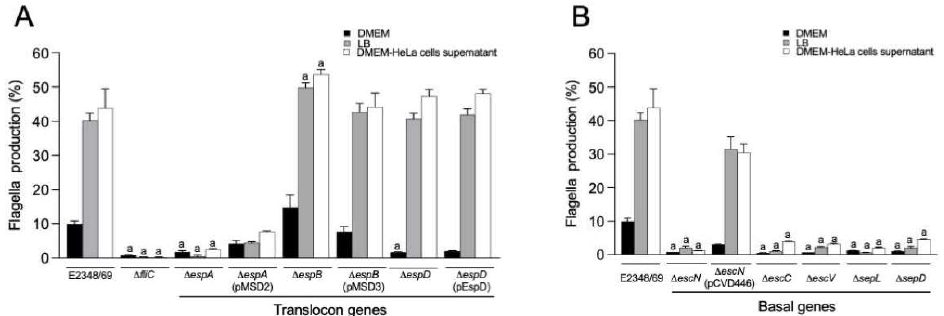
Figure 2. Growth conditions affect production of flagella by T3SS mutants. ( A , B ) Flow cytometry was used to quantitatively determine the production of flagella by translocon-associated Δ espA , Δ espB , and Δ espD mutants and the basal-body Δ escN , Δ escC , Δ escV , Δ sepL , and Δ sepL mutants, re- spectively. For these experiments the strains were grown as described in Materials and Methods.